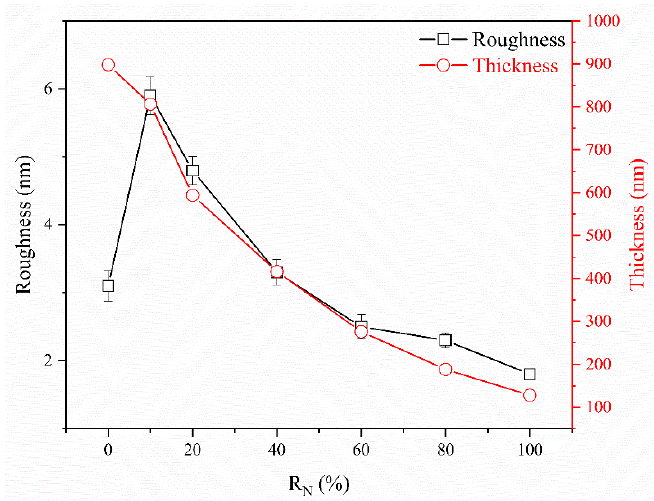
Figure 5. Surface roughness and thickness of (CrHfNbTaTiVZr)N coatings deposited at various R N .